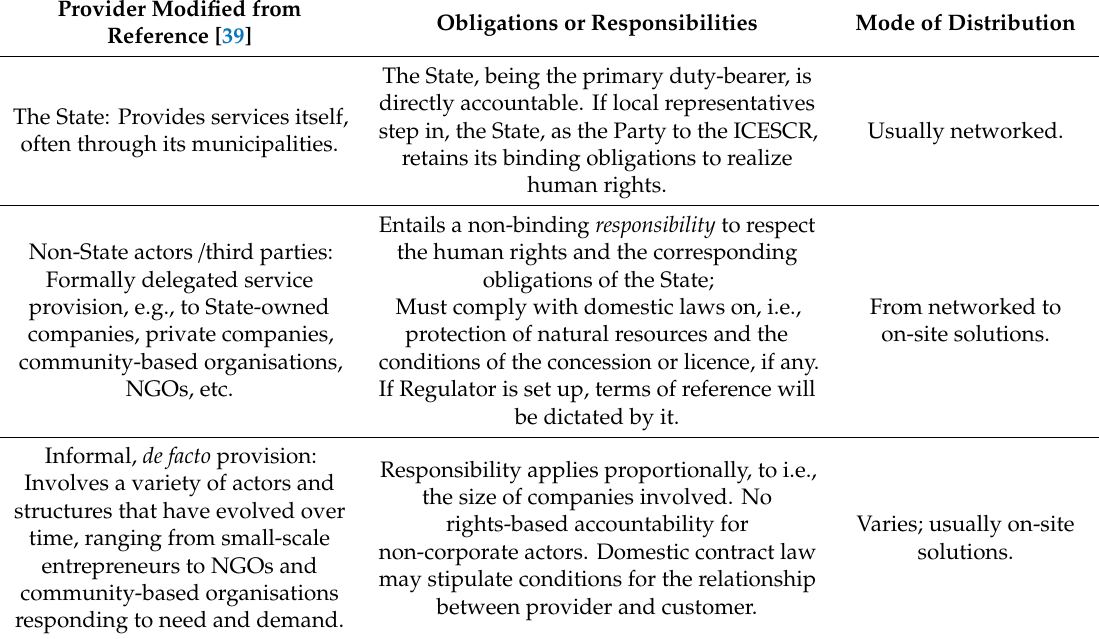
Table 1. Di ff erent forms of (ground)water services